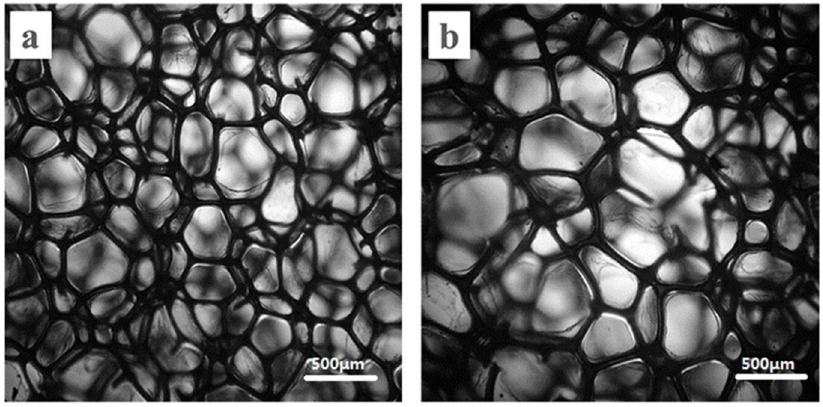
Figure 3. Optical microscope image (( a ) PUSF; ( b ) PUBF).